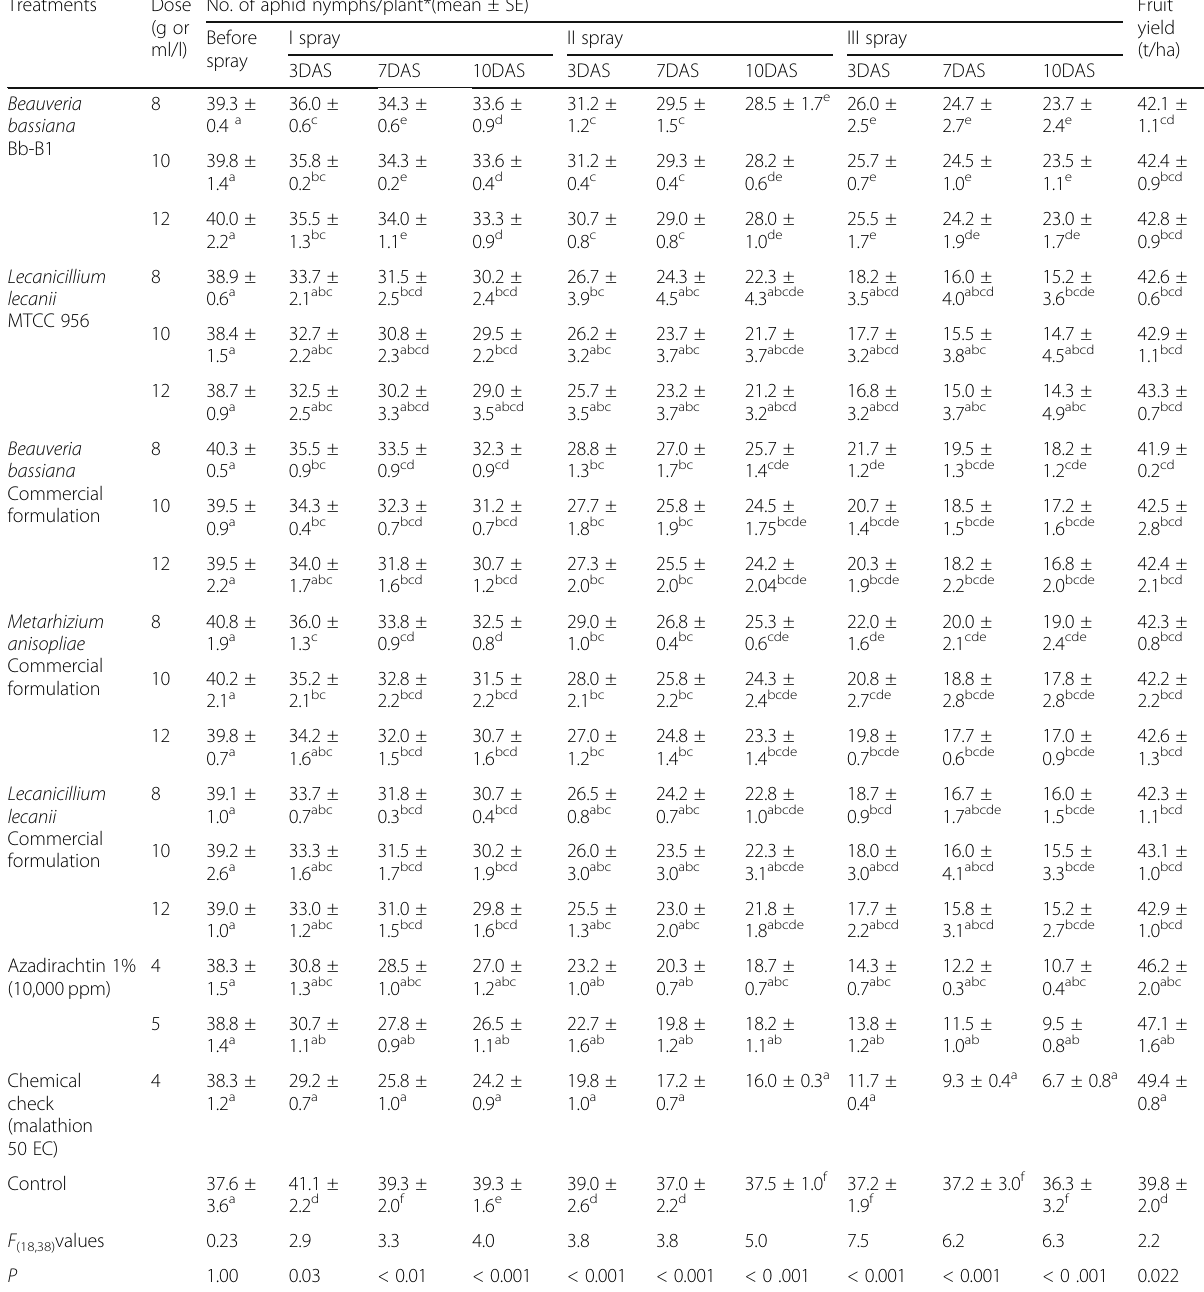
Table 1 Population dynamics of aphid, Myzus persicae (Sulzer) on capsicum plant treated with indigenous and commercial bioformulations under protected cultivation (2017, 2018) Treatments Dose (g or